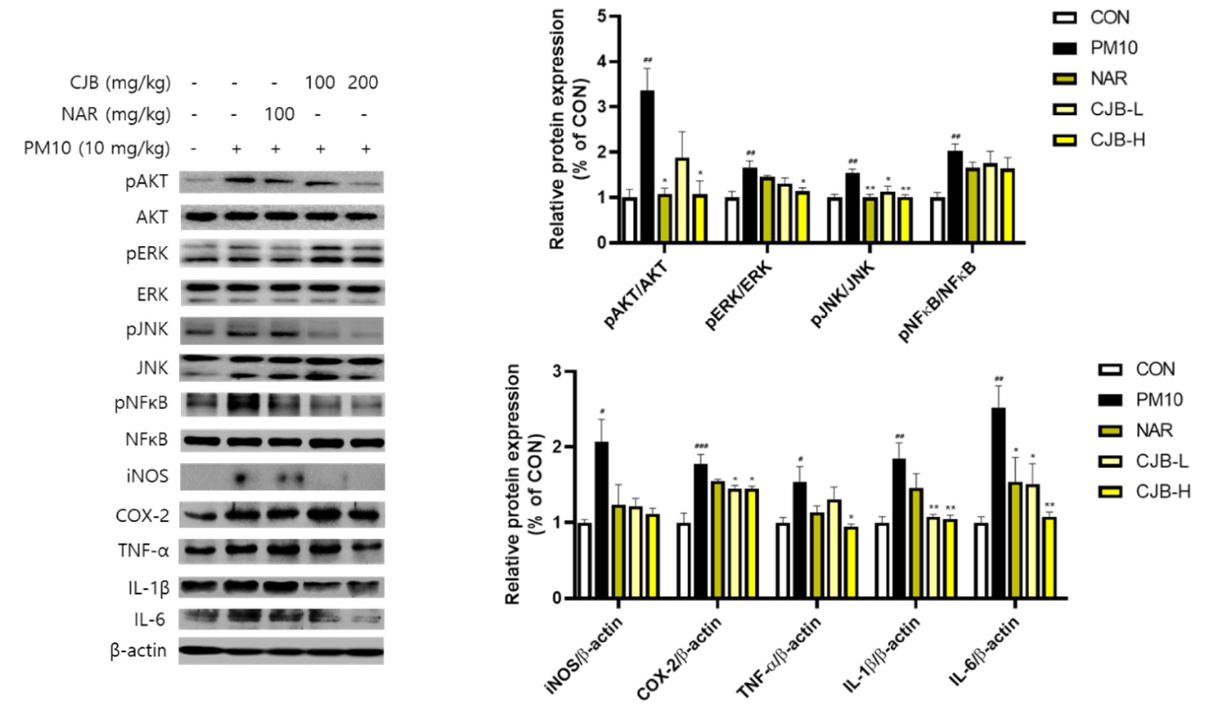
Figure 4. The expression of inflammatory proteins in the lung tissue from PM10-treated mice. All values are expressed as the mean ± SEM. A p -value under 0.05 was considered statistically significant. # , ## , and ### indicate statistical significance compared to the CON group, and * and ** indicate statistical significance compared to the PM10 group. CON, normal control; PM10, negative control; NAR, naringin at 100 mg/kg; CJB-L, CJB at 100 mg/kg; CJB-H, CJB at 200 mg/kg.